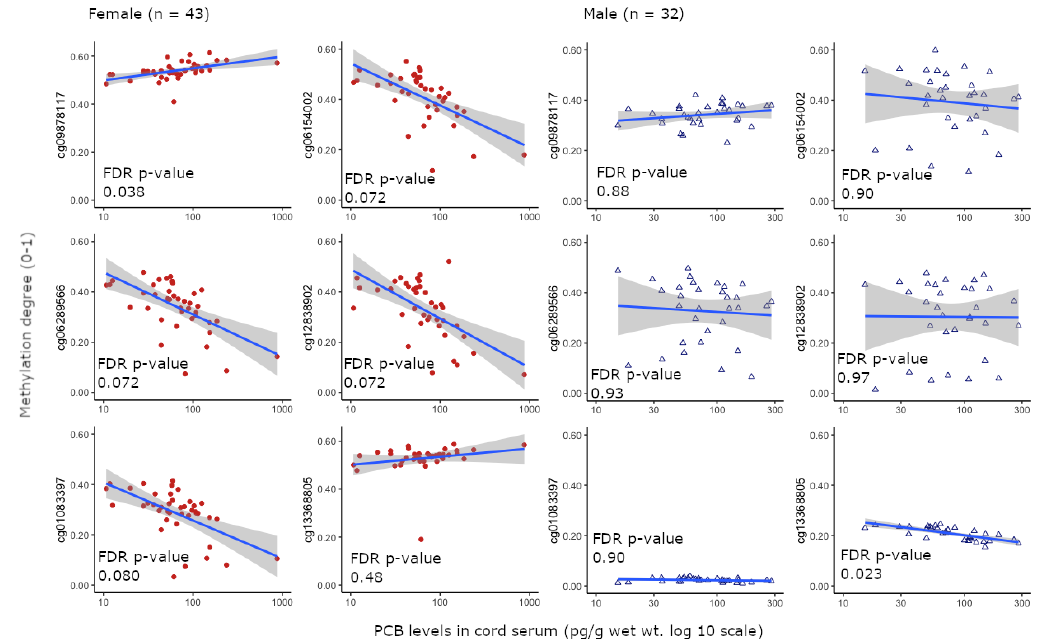
Figure 1. Relationship between maternal serum polychlorinated biphenyl (PCB) levels (pg/g wet weight) and DNA methylation degrees (0–1) six selected loci (cg09878117, cg06154002, cg06289566, cg12838902, cg01083397 and cg13368805) in cord tissue from male and female neonates revealed by correlation analysis (false discovery rate (FDR) < 0.1 in any one of gender) (gray 95% CI of single linear regression model). * Red circle ●: female newborns (n = 43: median 72 pg/g wet), blue triangle △ : male newborns (n = 32: median 66 pg/g wet). Table 4. Genes in cord tissue showing altered methylation degrees in relation to maternal PCB exposure according to correlation analysis.